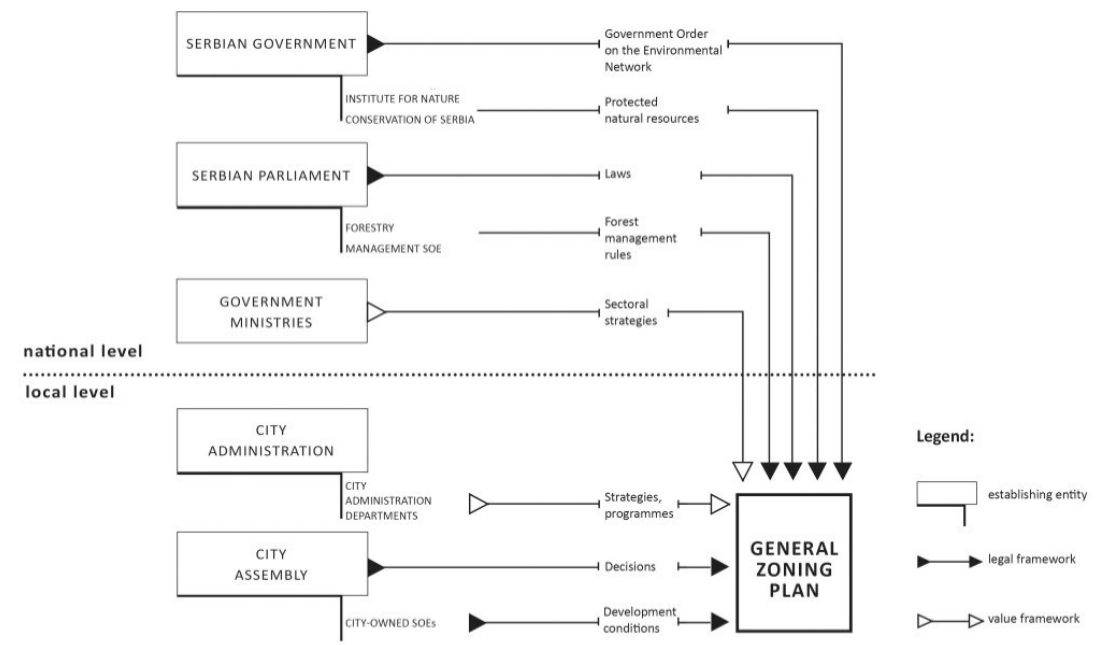
Figure 1. Formal cooperation procedures between institutions for land use planning related to urban forest management in Serbia (source: Authors).